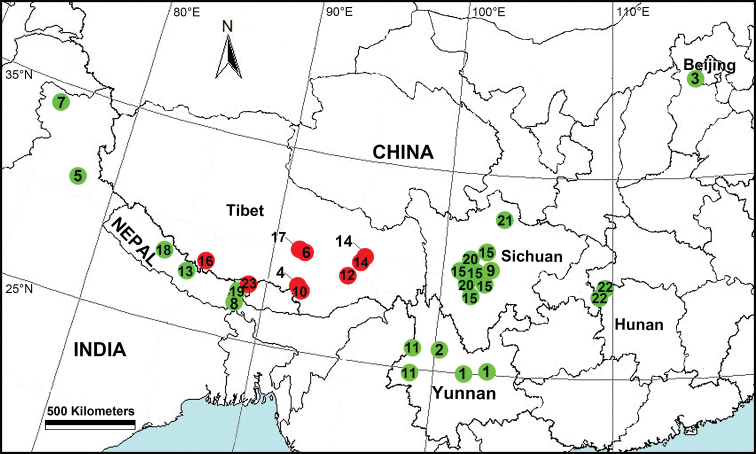
Distribution of Pimoa species from Asia. Red dots represent new species, green dots represent previously described species. 1P.
anatolica2P.
binchuanensis3P.
clavata4P.
cona sp. nov. 5P.
crispa6P.
duiba sp. nov. 7P.
gandhii8P.
indiscreta9P.
lata10P.
lemenba sp. nov. 11P.
lihengae12P.
mainling sp. nov. 13P.
nematoides14P.
nyingchi sp. nov. 15P.
reniformis16P.
rongxar sp. nov. 17P.
samyai sp. nov. 18P.
sinuosa19P.
thaleri20P.
trifurcata21P.
wanglangensis22P.
xinjianensis23P.
yadong sp. nov.